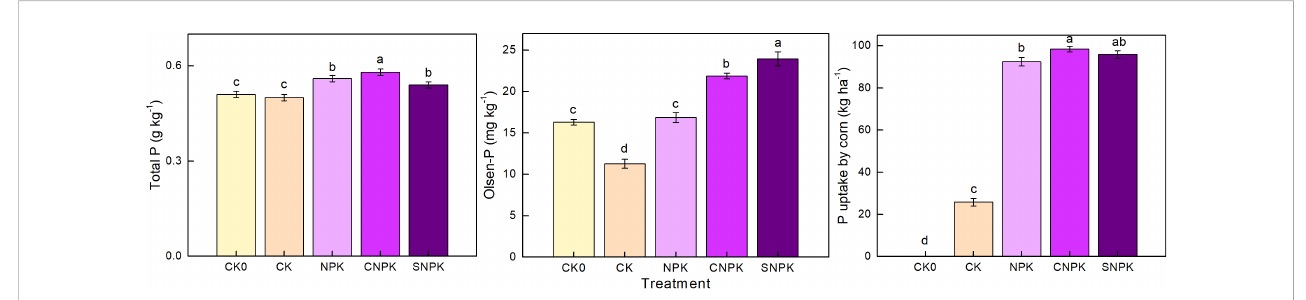
FIGURE 2 Effects of the different treatments on soil total P, Olsen-P, and P uptake by corn. Error bars represent standard deviation, n = 3. Different letters in a column indicate signi fi cant differences at the 0.05 level. CK0: initial soil; CK: non-fertilizer; NPK: NPK fertilizer; CNPK: biochar + NPK fertilizer; SNPK: corn stover + NPK